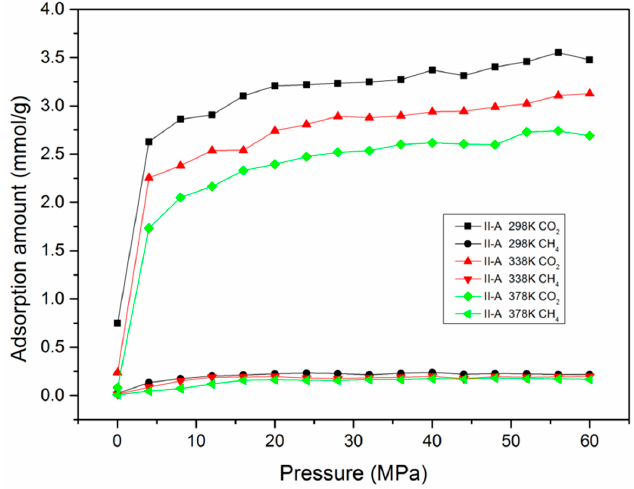
Figure 4. The adsorption amounts of a CO 2 /CH 4 binary mixture in type II-A kerogen with pressure at different temperatures.